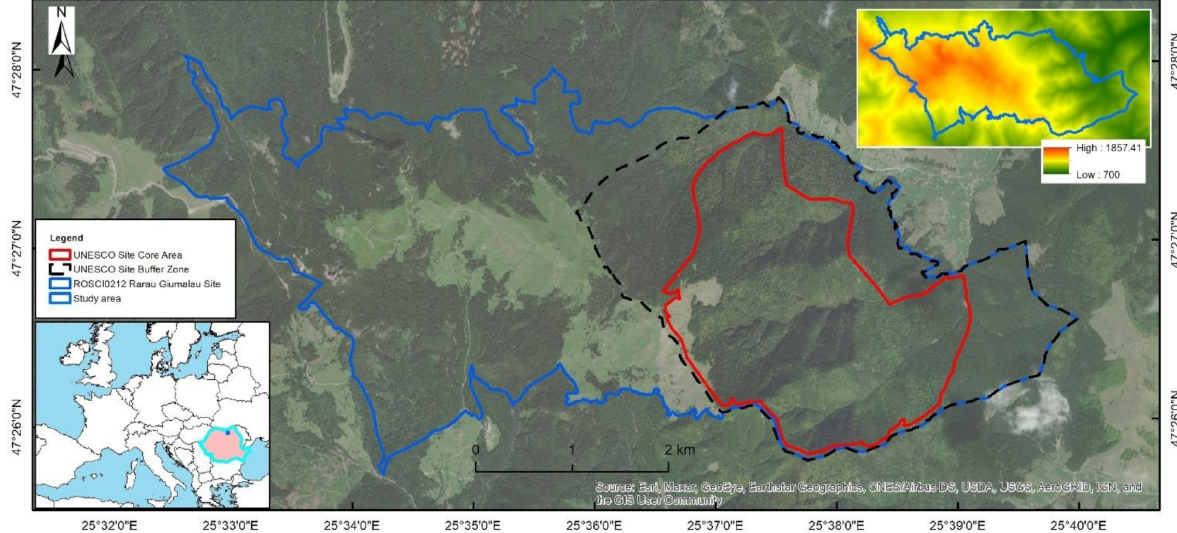
Figure 1. Study location—Sl ă tioara-Rar ă u area (reserve boundaries from http://mmediu.ro/articol/date-gis/434, (accessed on 15 October 2020). overlaid on the satellite images from ESRI ArcGIS server). Maps throughout this book were created using ArcGIS ® software by Esri. ArcGIS ® and ArcMap™ are the intellectual property of Esri and are used herein under license. Copyright © Esri. All rights reserved. For more information about Esri ® software, please visit